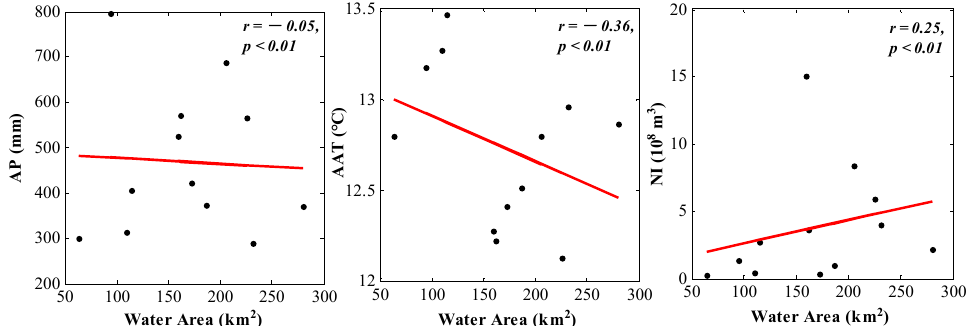
Figure 15. The Pearson correlation coefficient between water area and annual average temperature (AAT), annual precipitation (AP), and natural inflow (NI) from 1989–2000.